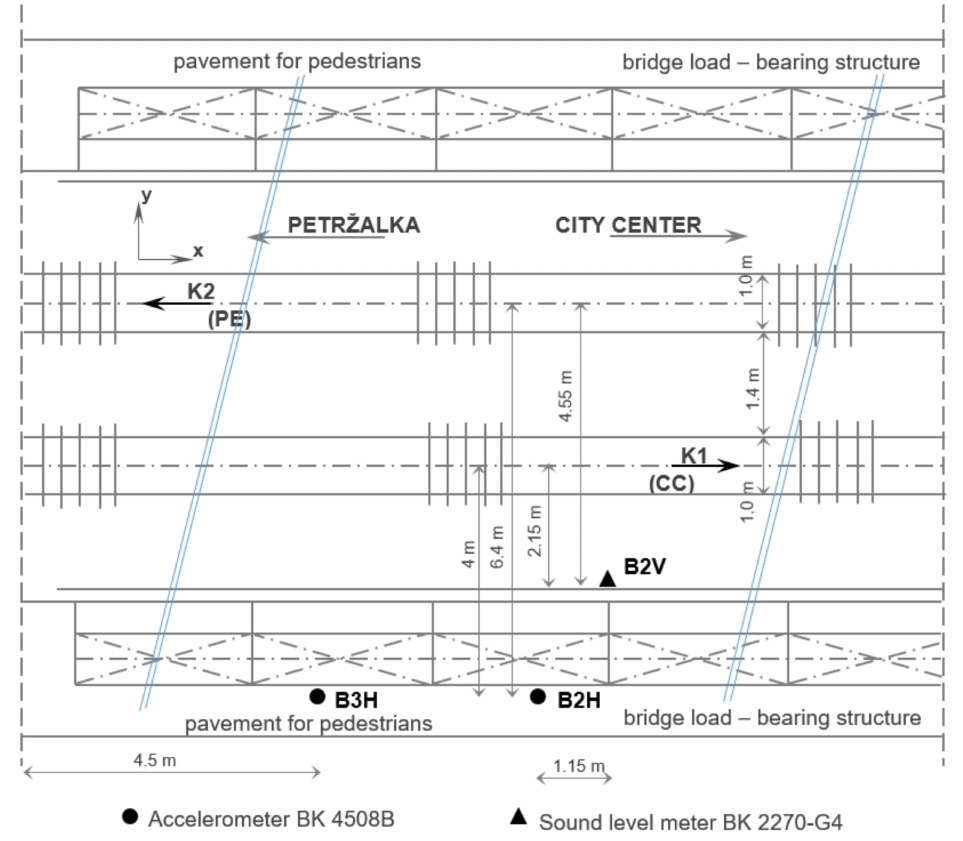
Figure 15. Location of measured points B2H, B3H (B2V) in the location on the Old